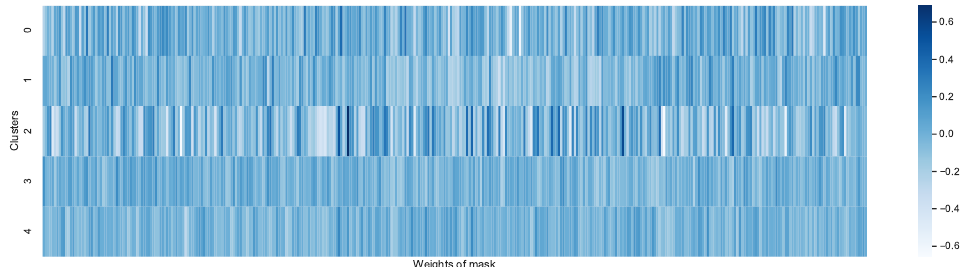
Figure 8. Weight visualization of diverse